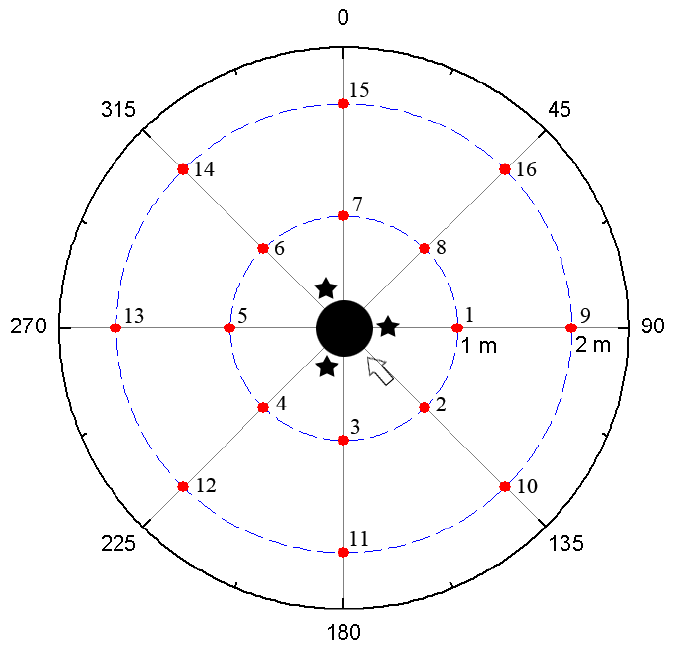
Figure 12. Positions of